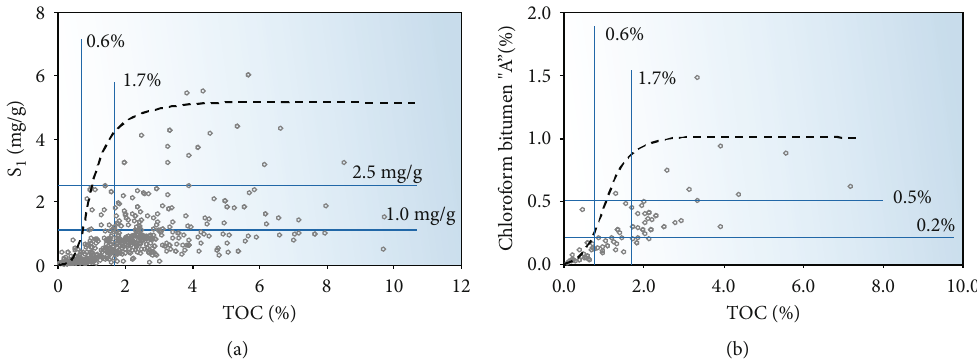
Figure 5: Relationships between (a) TOC and S and (b) TOC and chloroform bitumen “ A ” in the Es 1L of the Raoyang Sag (data from the 1 PetroChina Huabei Oil fi eld Exploration Development Research